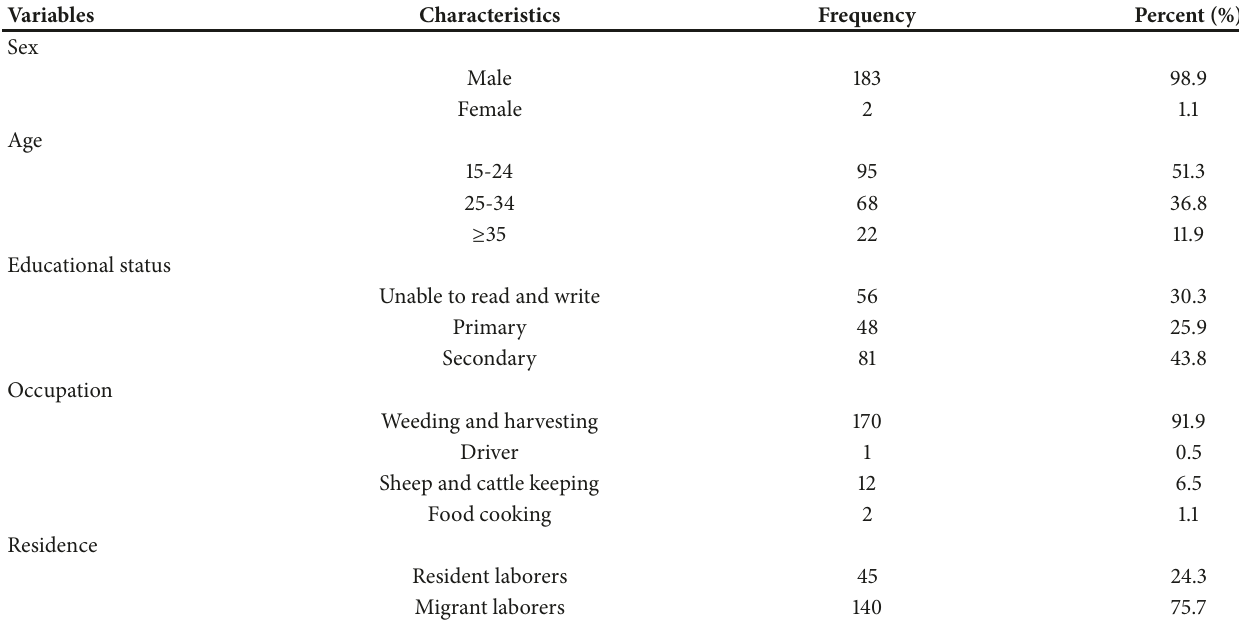
Table 1: Sociodemographic characteristics of the study